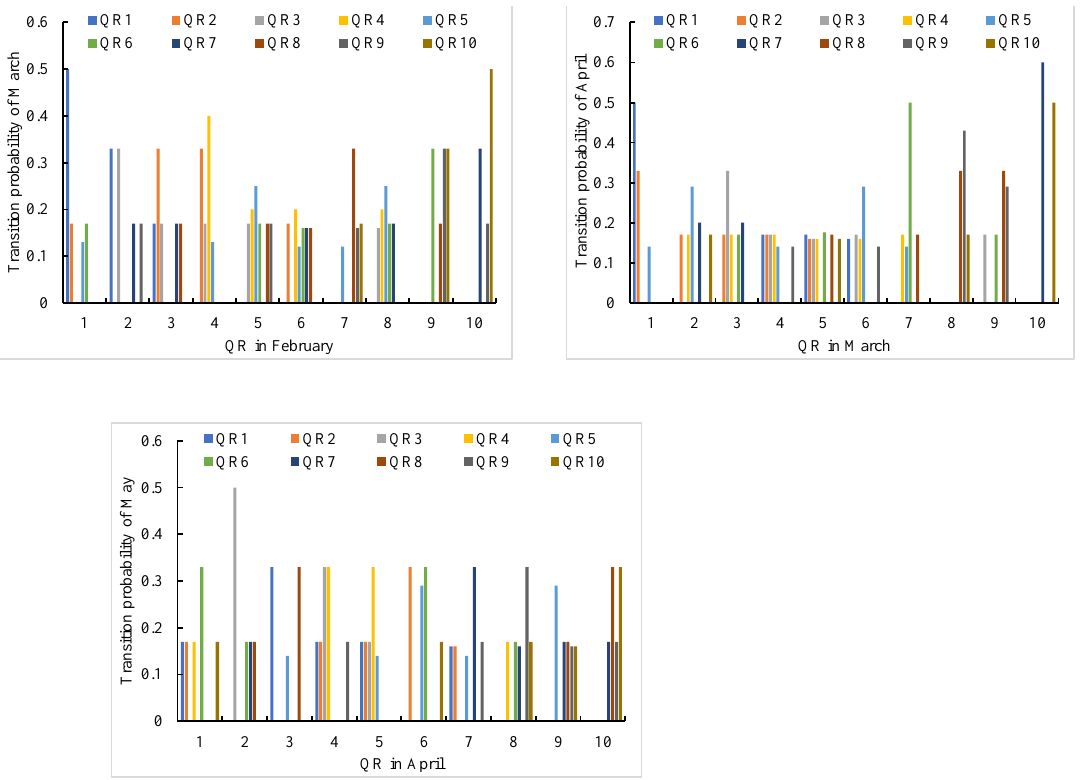
Figure 9. Transfer probability of the NZD hydropower plant for measured runoff. Table 4. Representative flow in each month for simulated runoff of the NZD hydropower plant (10 8 m 3